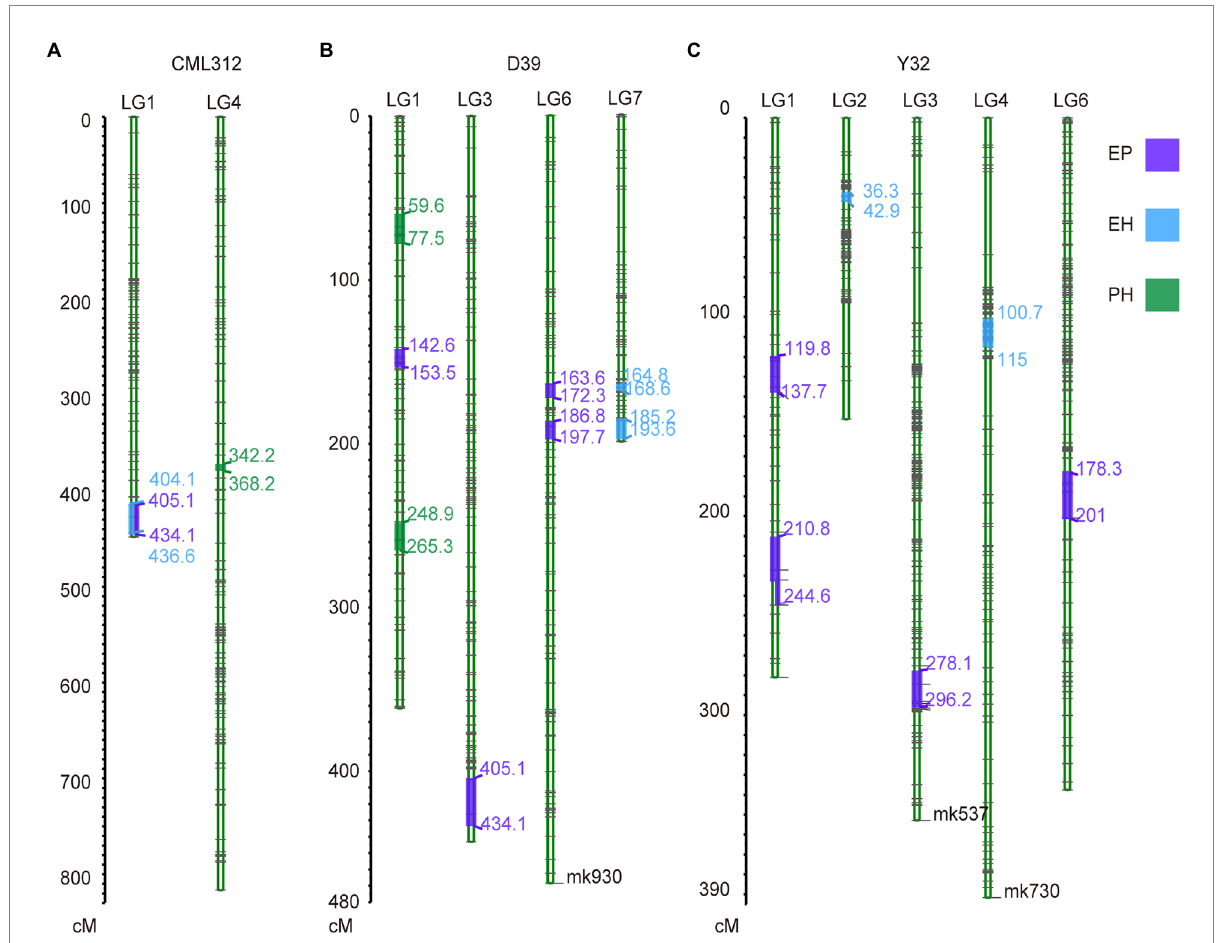
FIGURE 6 Genetic linkage map and QTL mapping for CML312 population (A) , D39 population (B) and Y32 population (C)